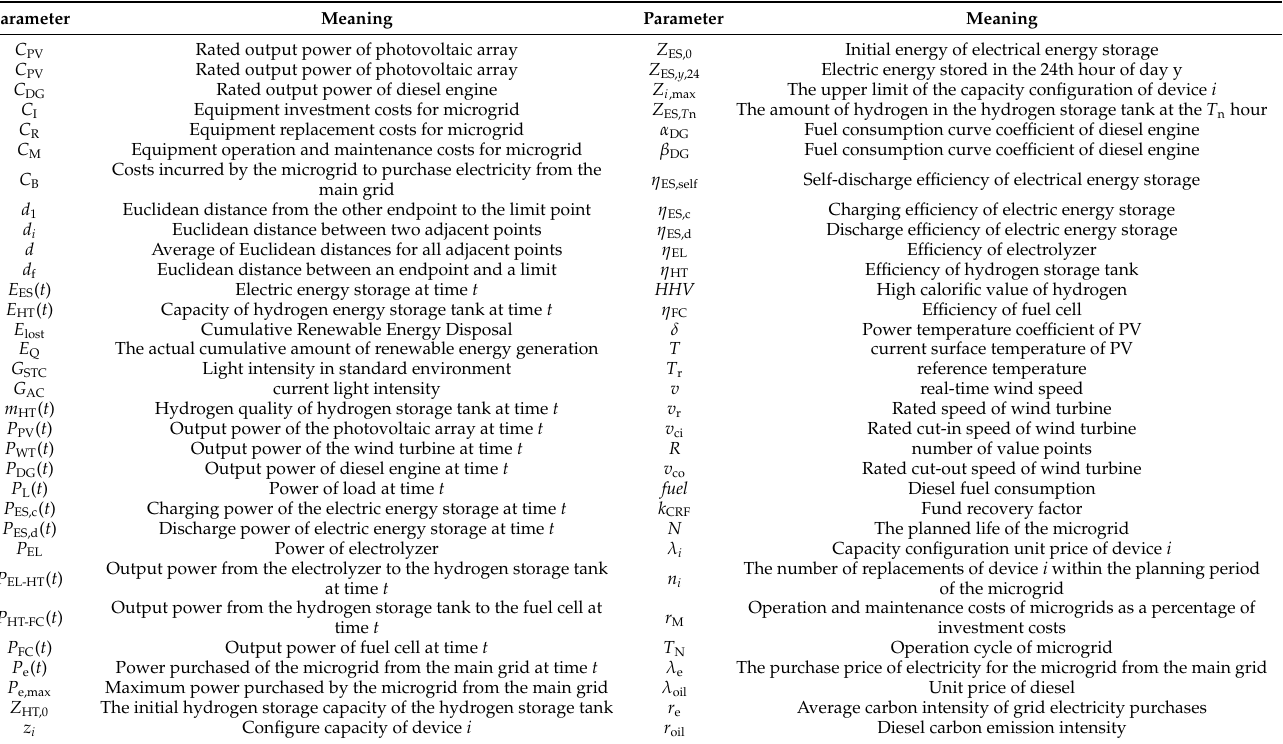
Table 1. Relevant Parameters of Microgrid and Their